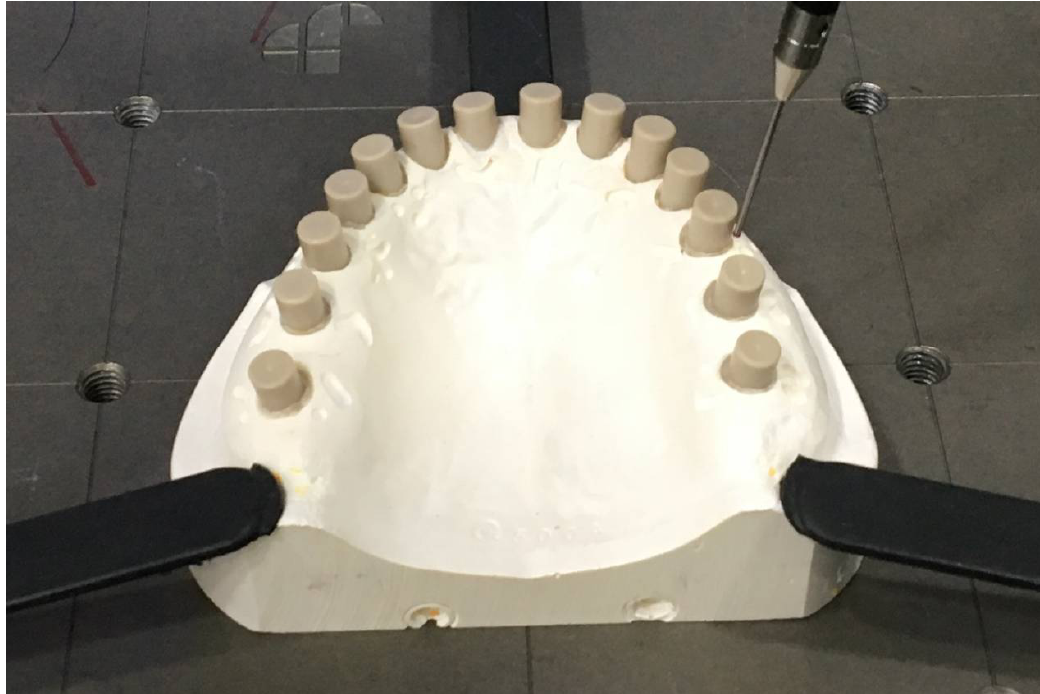
Figure 4. Measurements of the master model using a computerized coordinate measuring machine.